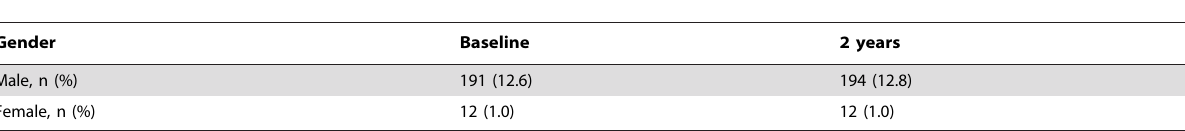
Table 4. Prevalence of hyperuricemia (male, n= 1,515; female, n= 1,257).